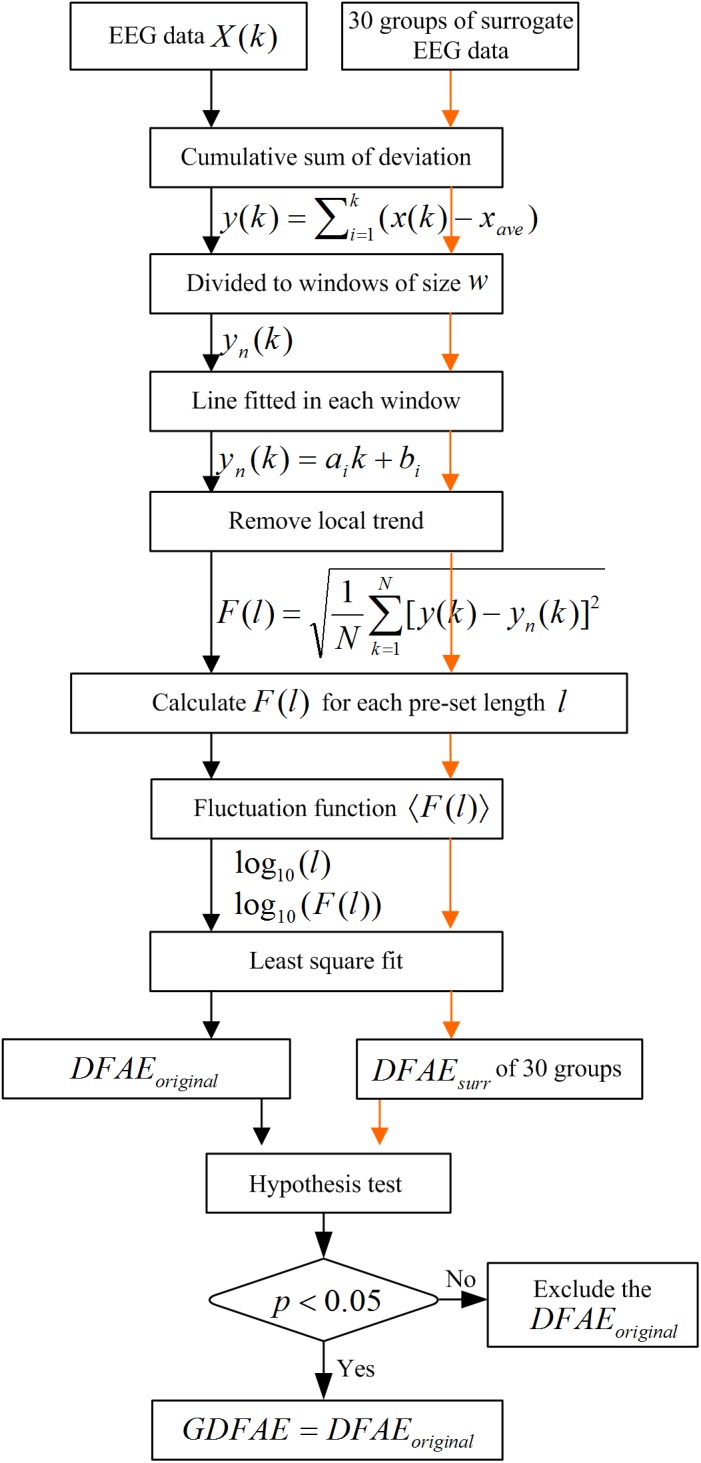
Flow diagram for GDFAE calculation.